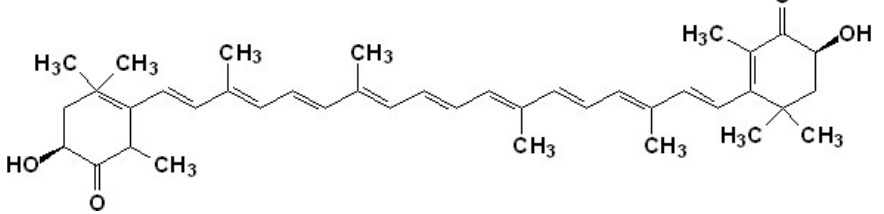
Figure 2. Chemical structure of the marine carotenoid astaxanthin